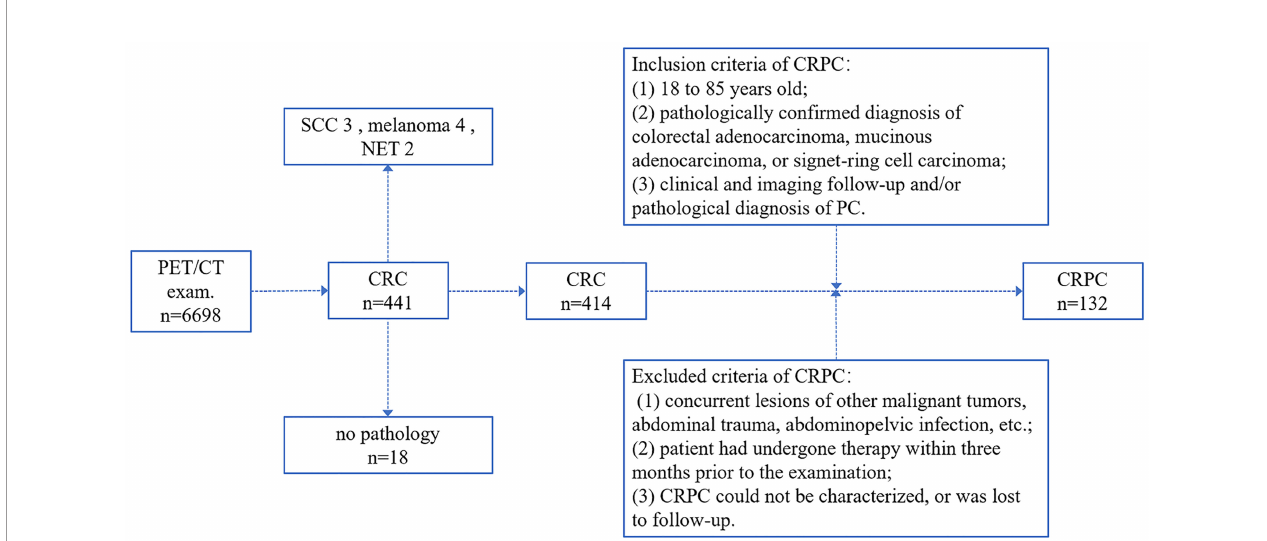
FIGURE 1 | The colorectal peritoneal carcinomatosis (CRPC) patient inclusion process. CRC, colorectal cancer; PC, peritoneal carcinomatosis; SCC, squamous cell carcinoma; NET, neuroendocrine